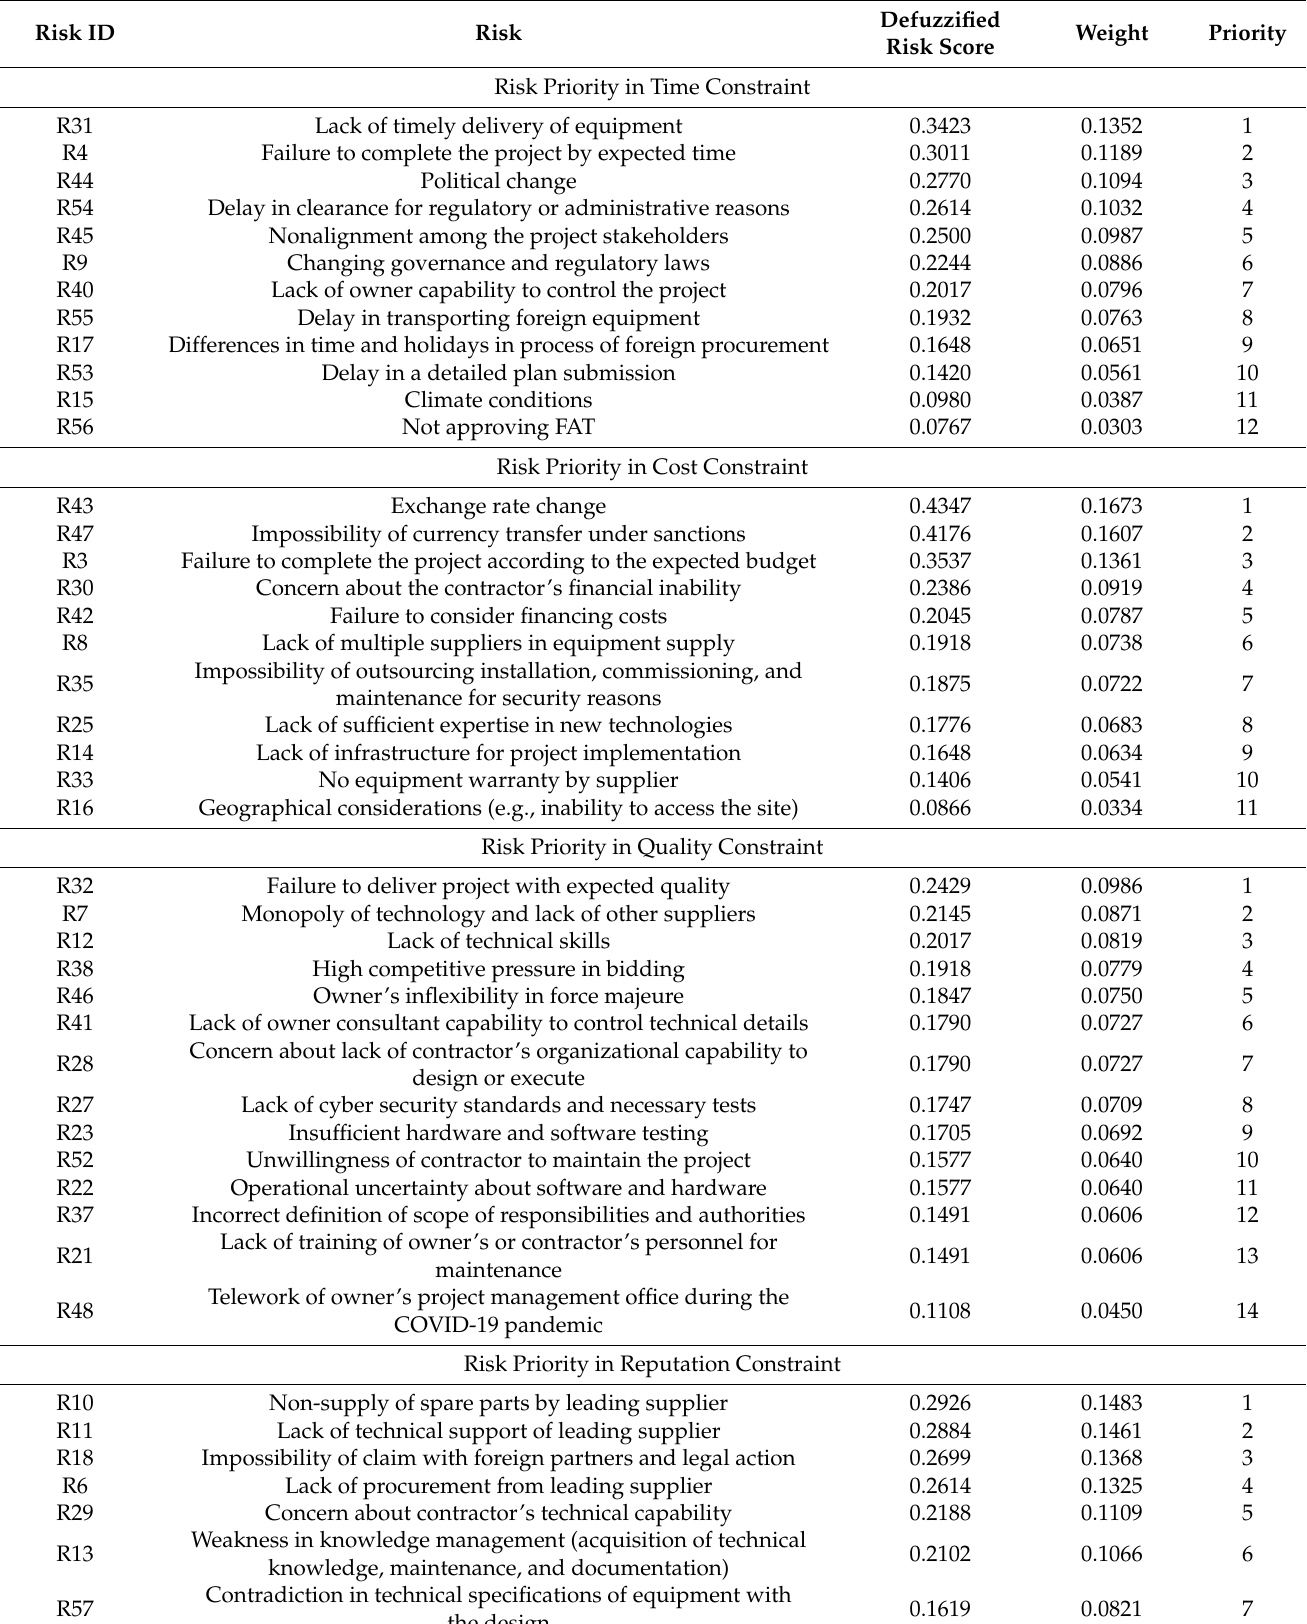
Table 4. The most important risks in each competing